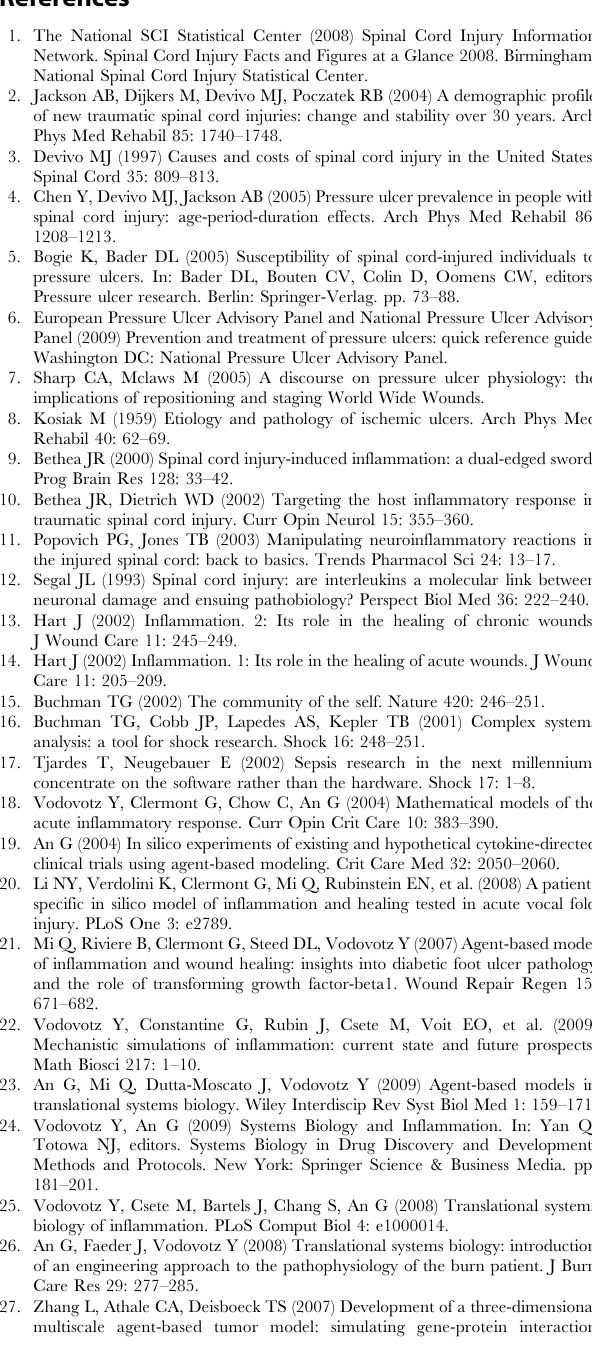
Figure S1 A sample reactive hyperemia experiment blood flow profile. (TIF) Text S1 A detailed description of rules and parameters for the agent-based portion of the model.